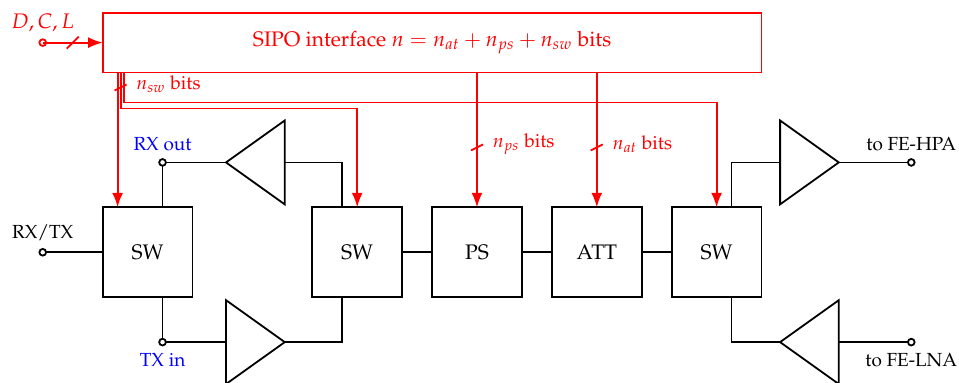
Figure 1. Basic block diagram of a microwave core-chip. The SIPO interface (red) controls the RF analog part which includes a phase shifter (PS), an attenuator (ATT) and some switches (SW). All amplifiers are optional and the TX input/RX output can either have separate pads (blue) or share the same pad, hence the number of switches depends on the specific CC architecture